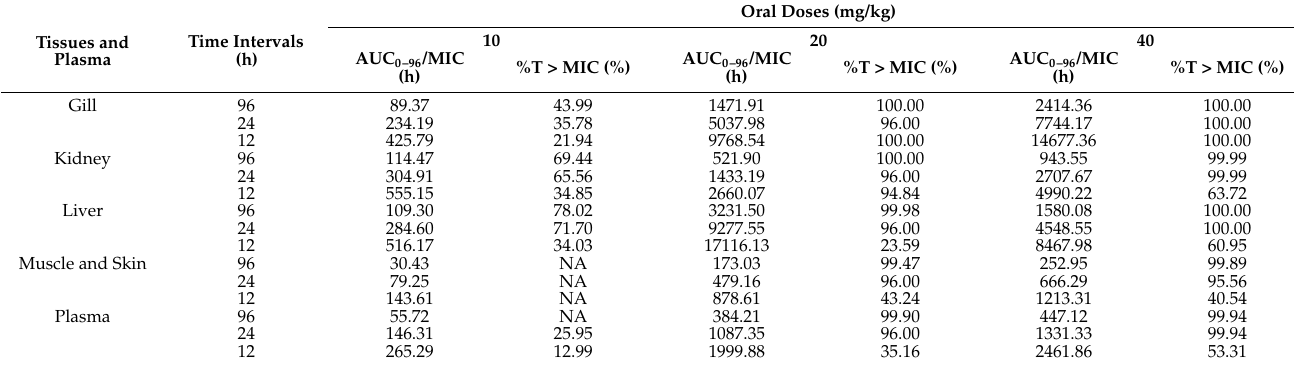
Table 3. The pharmacokinetic–pharmacodynamic parameters of doxycycline in gill, kidney, liver, muscle and skin, and plasma of yellow catfish ( Pelteobagrus fulvidraco ) given an oral dose of 10, 20, and 40 mg/kg at administration intervals of 96, 24, and 12 h, respectively.